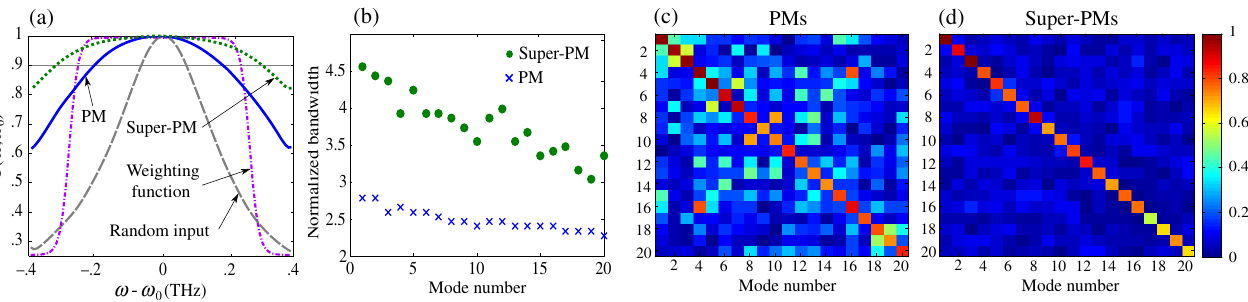
FIG. 2. (a) Measured spectral correlation function C ð ω ; ω 0 Þ for the output signals of the widest PM (blue solid line) and for the widest super-PM obtained from our bandwidth optimization (green dotted line). The weighting function W ð ω Þ used in the cost function of Eq. (3) is shown as a purple dash-dotted line. The gray dashed line shows the spectral correlation of a random input. The horizontal solid gray line indicates the threshold value C ð ω ; ω 0 Þ ¼ 0 . 90 that sets the correlation width. (b) Spectral correlation width of super-PMs and PMs normalized by that of a random input. Our optimization scheme found 20 super-PMs that have a larger bandwidth than the widest PM. The orthogonality of the output-field patterns for the 20 widest PMs (c) and the 20 super-PMs (d). In the presence of loss, the PMs are not orthogonal but the super-PMs